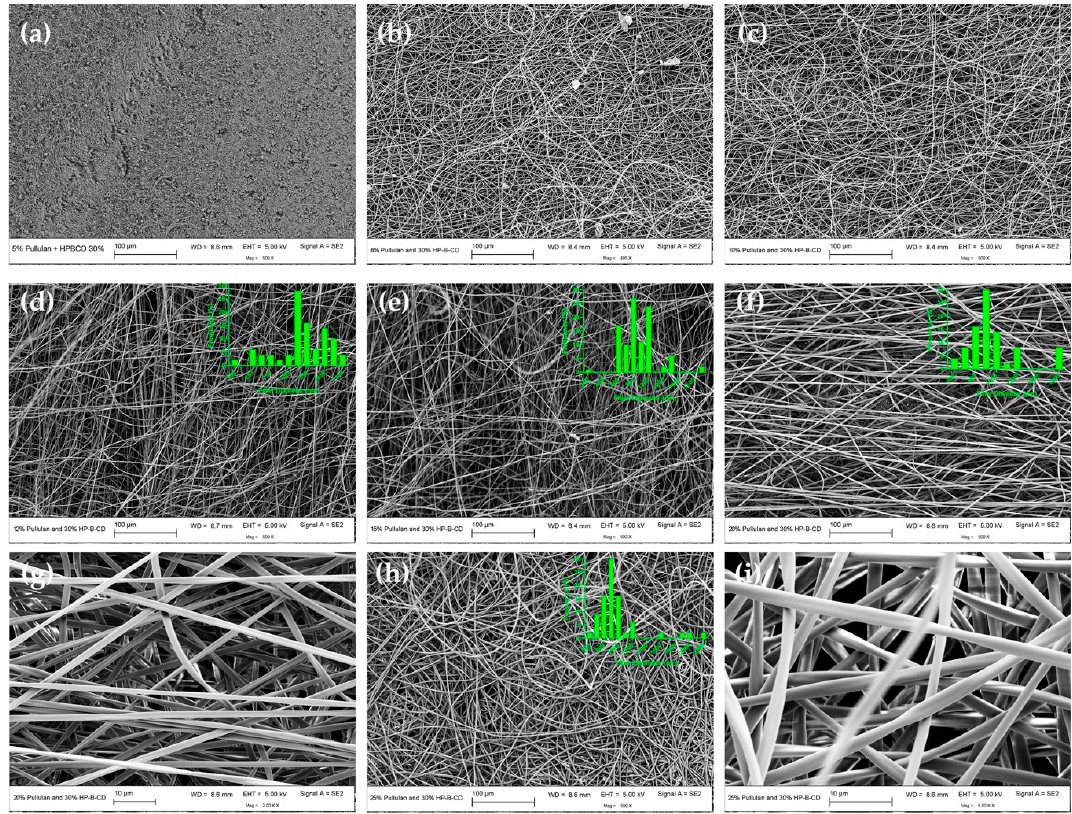
Figure 6. SEM images and diameter histograms of electrospun fibers containing 30% (w / v) HP- β -CD and different pullulan contents: ( a ) 5, ( b ) 8, ( c ) 10, ( d ) 12, ( e ) 15, ( f ) and ( g ) 20 and ( h ) and ( i ) 25% (w/v). Fiber size distributions are only presented for smooth and bead-free spunfibers.